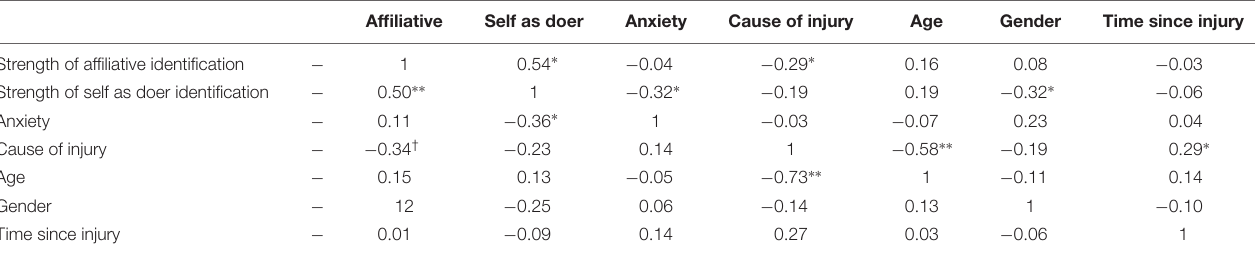
TABLE 2 | Correlations between identification, anxiety and demographic variables (time 1 correlations are above the diagonal and time 2 correlations below). Affiliative Self as doer Anxiety Cause of injury Age Gender Time since injury